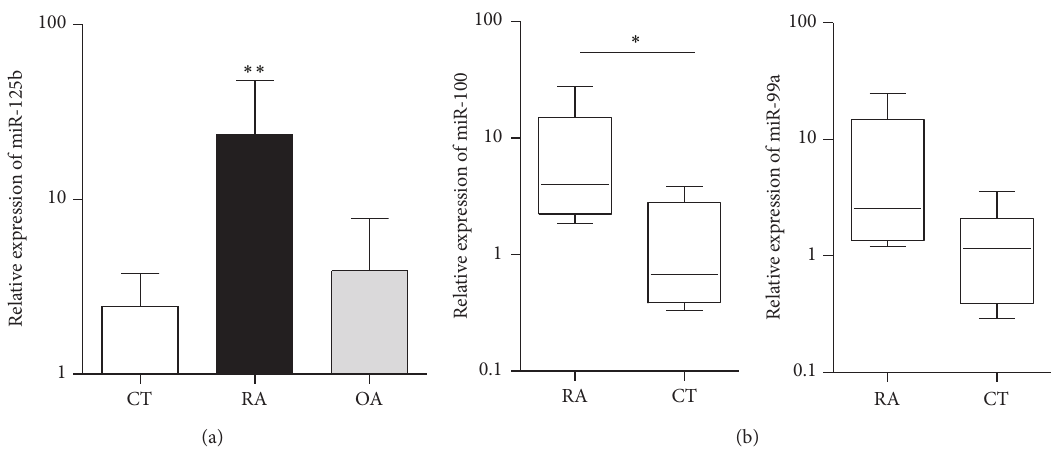
Figure 1: miR-125b is overexpressed in RA blood. (a) Expression levels of miR-125b in blood of healthy individuals (CT, 𝑛 = 13 ) and patients with osteoarthritis (OA, 𝑛 = 5 ) and rheumatoid arthritis (RA, 𝑛 = 16 ). (b) Expression levels of miR-100 and miR-99a in blood samples from CT ( 𝑛 = 7 ) and RA patients ( 𝑛 = 6 ). ∗ 𝑃 < 0.05 , ∗∗ 𝑃 < 0.01 as determined by Mann-Whitney